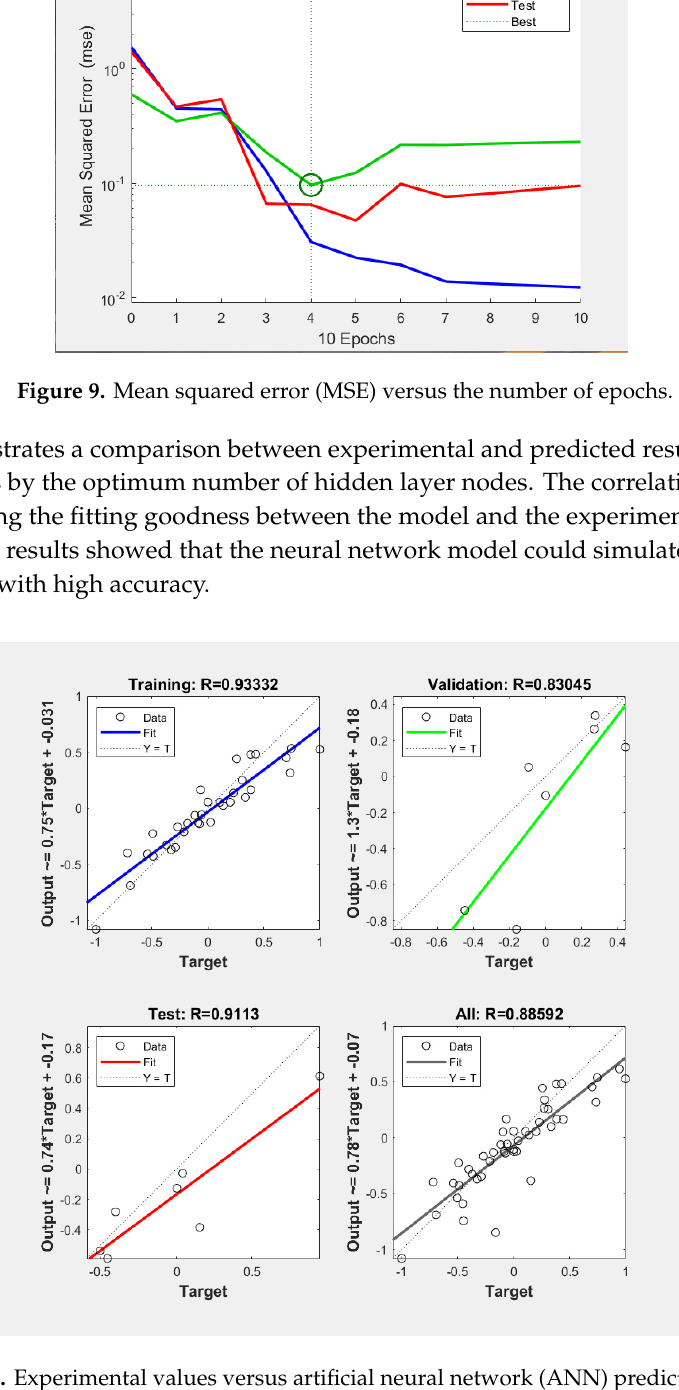
Table 4. Prediction results of BP neural network.